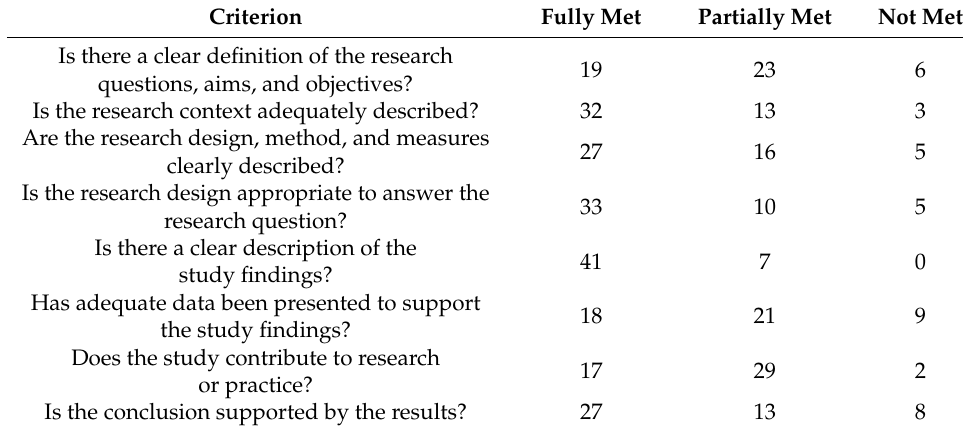
Table 3. Quality assessment results.